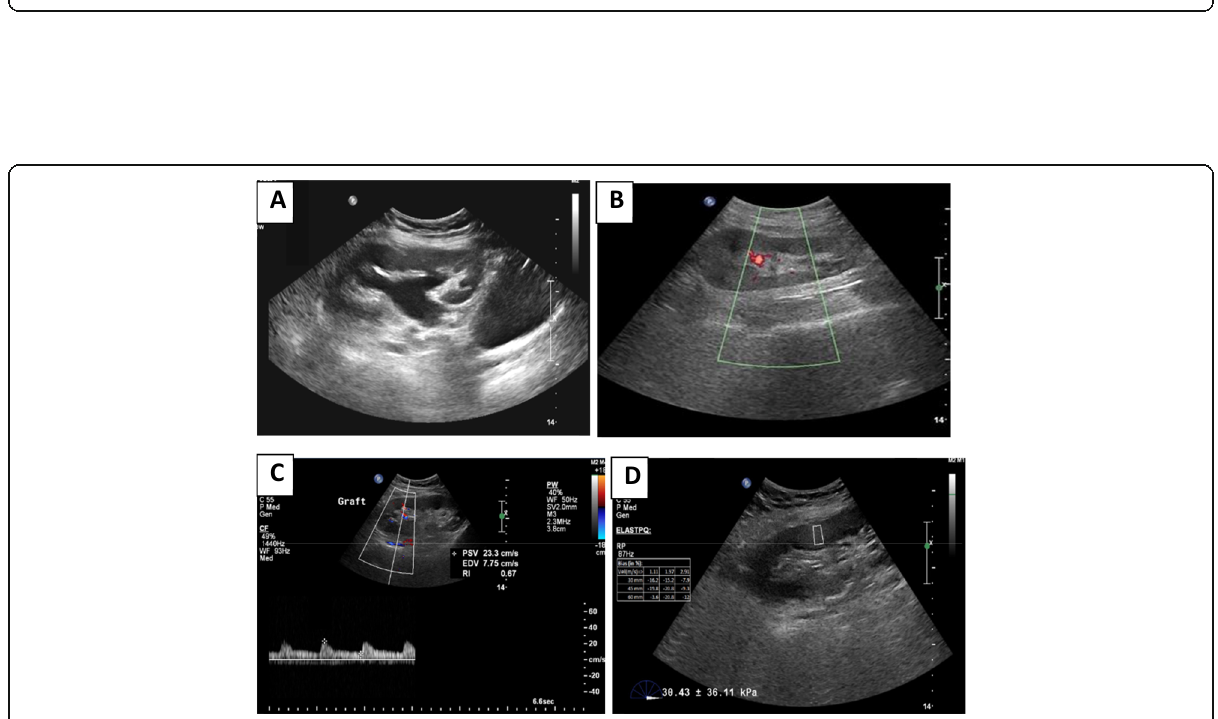
Fig. 3 A 24-year-old female patient who underwent renal transplantation in 2013, during follow-up at 19 December 2017, was presented with creatinine level 1.3 mg/dl and graft impairment. a Graft US showed average size graft at the right iliac region with normal echo pattern and mild hydronephrosis with full UB, after micturition no hydronephrosis anymore, no peri-graft collection. b Power Doppler US shows patchy cortical perfusion. c Duplex Doppler US showed average RI = 0.67. d Mean sono-elastography at transplanted kidney measured 30.43 + 36.11 Kpa. Histopathology diagnosis by the US-guided biopsy: chronic allograft injury